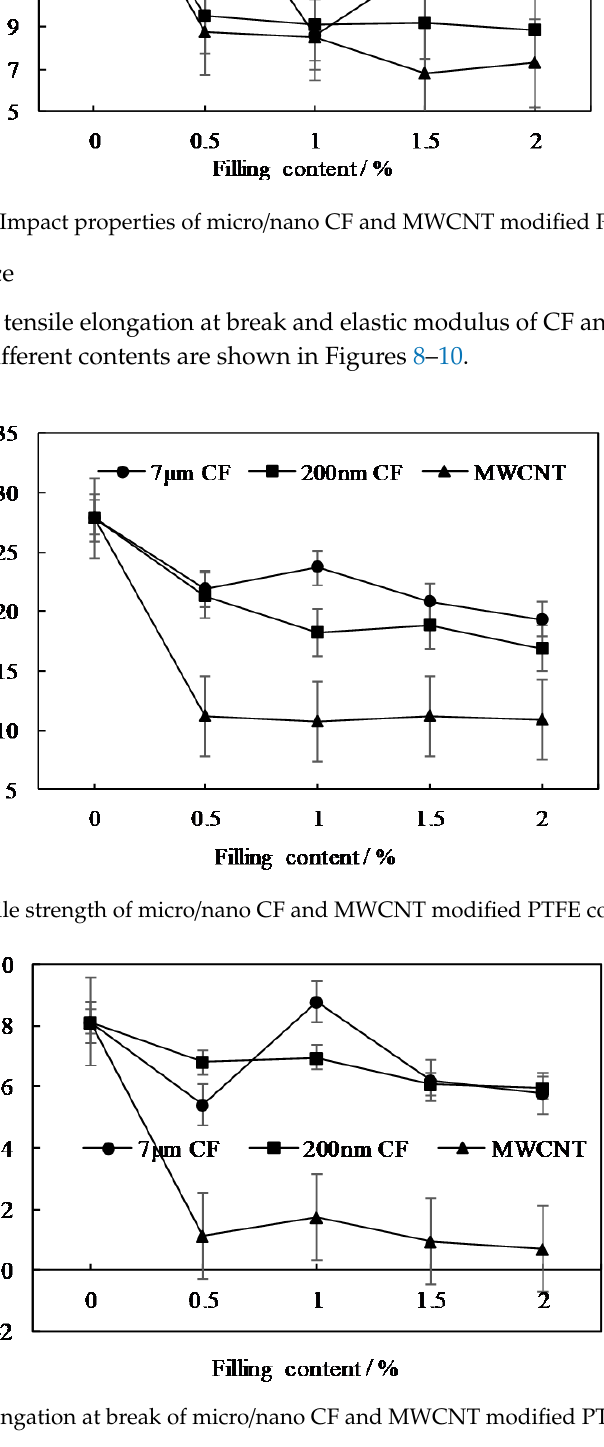
Figure 10. Elastic modulus of micro/nano CF and MWCNT modified PTFE composites. It can be seen from Figures 8 and 9 that the tensile strength and elongation at break of PTFE were significantly reduced after adding CF and MWCNT. Among them, when the addition amount of 7 μm CF was 0.5%, the tensile strength of the PTFE composite material decreased from 27.9 to 21.87 MPa, which was about 20%, and the tensile elongation at break decreased from 810% to 541%. With the increase of CF to 1%, the tensile strength of the composite material increased to 23.64 MPa, and the tensile elongation at break also rose to the original level. Then, as the CF increased, the tensile strength slowly decreased. Compared with CF, when the addition amount of MWCNT was 0.5%, the tensile strength and tensile elongation at break of PTFE composites dropped significantly to 11.19 MPa and 111%, respectively, with a decrease of about 60% and 87%.